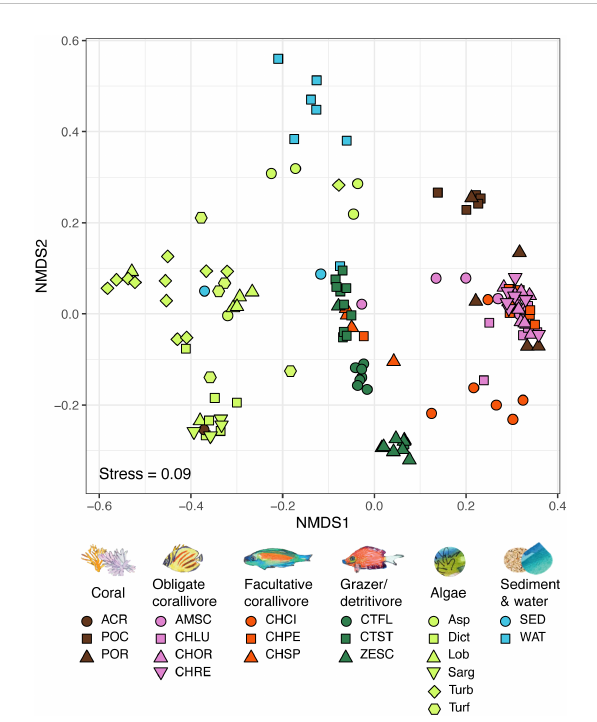
FIGURE 2 NMDS of bacterial communities based on the 16S rRNA gene in coral reef-associated environmental pools: obligate and facultative corallivore feces, grazer/detritivore feces, corals, algae, sediment and water (see Table S1 for sample sizes). Bacterial communities in all environmental pools differed signi fi cantly from each other (overall PERMANOVA results: R 2 = 0.17, F (5, 107) = 4.1, p < 0.001, pairwise PERMANOVA results: R 2 ≥ 0.08, F > 2.6, Bonferroni-adjusted p-values ≤ 0.005; see Table S3). Bacterial assemblages also signi fi cantly differed between most species/sample types (overall PERMANOVA results: R 2 = 0.41, F (20,104) = 2.9, p < 0.001; see Table S4). PERMANOVA results are based on Bray-Curtis distances